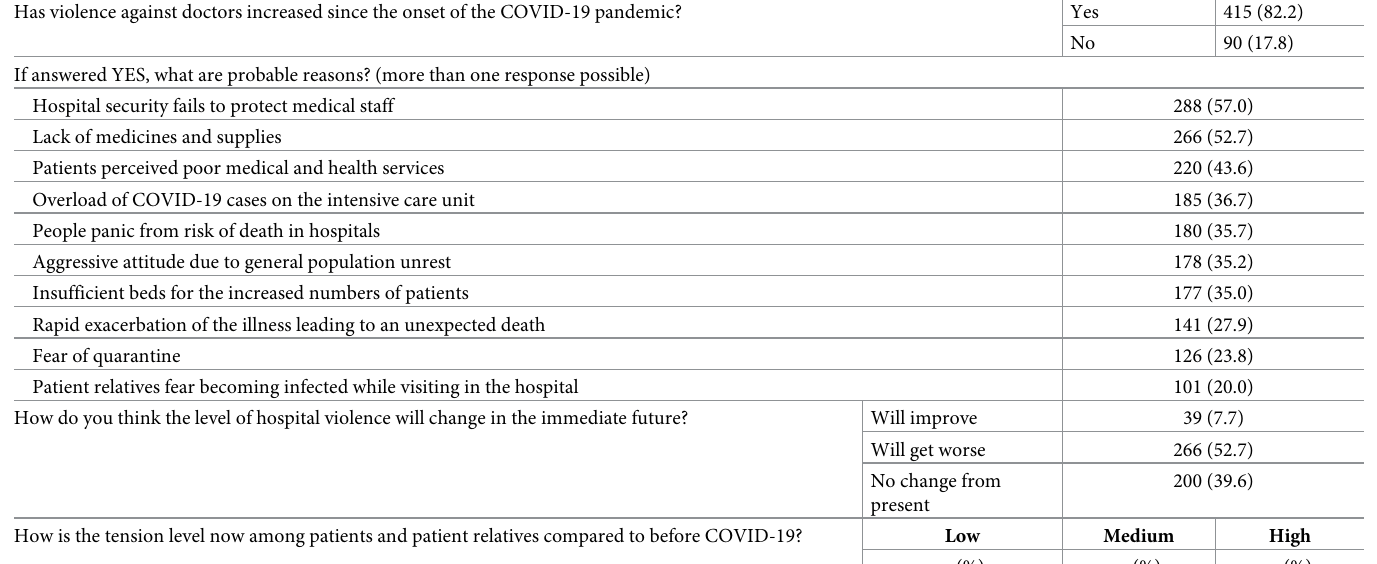
Table 3. Hospital violence. Levels of hospital